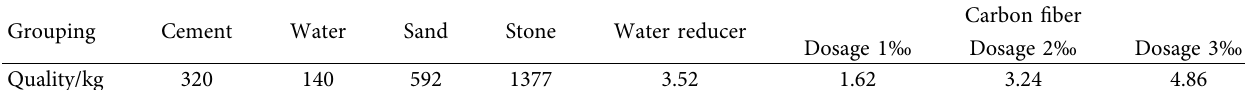
Table 2: Carbon fiber-modified airport road surface concrete ratio design.